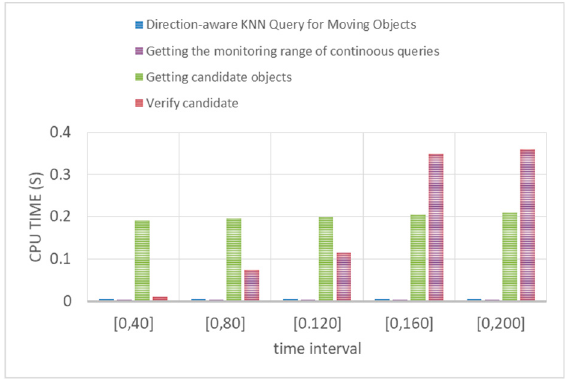
Figure 15. Time-consuming for each stage of continuous query in different time intervals.